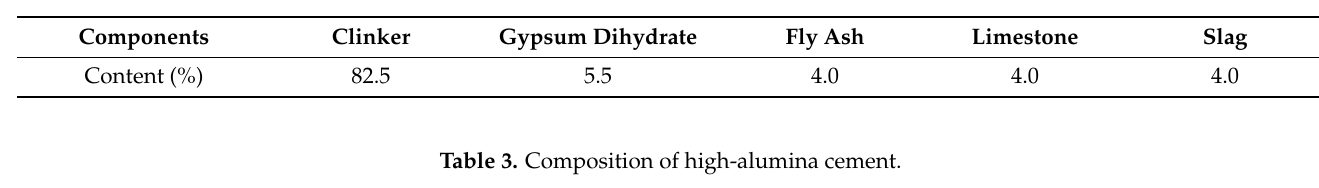
Table 2. Composition of P.O.42.5R cement.